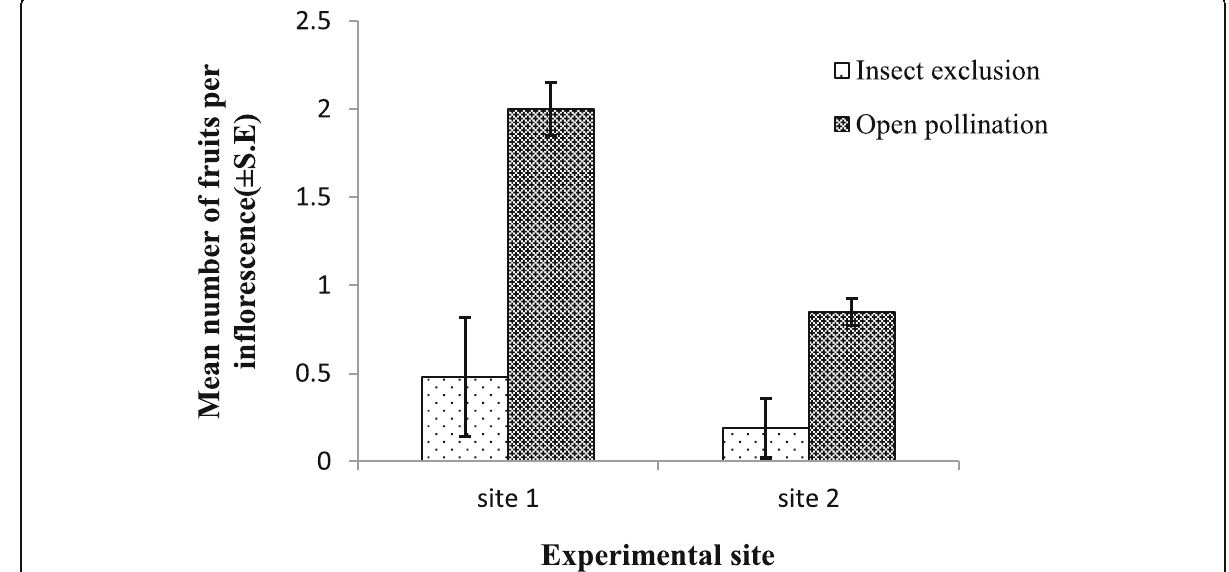
Fig. 4 Mean number of matured fruits produced per inflorescence in the Guinea savanna zone of